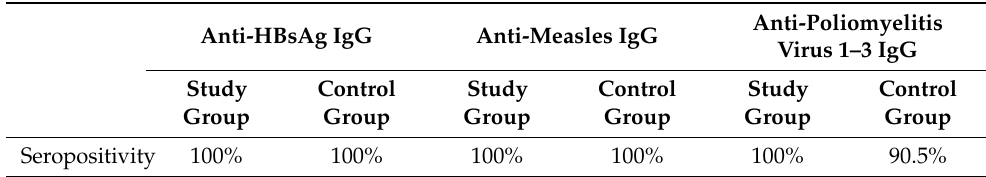
Table 5. Seropositivity after vaccination against hepatitis B, polio, and measles in children of post- transplant mothers (study group) and children from the general paediatric population (control group).